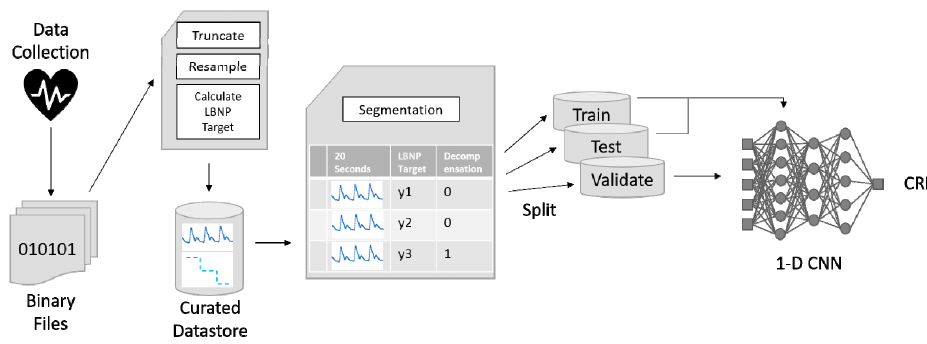
Figure 1. Data-processing pipeline for CRM algorithm development.